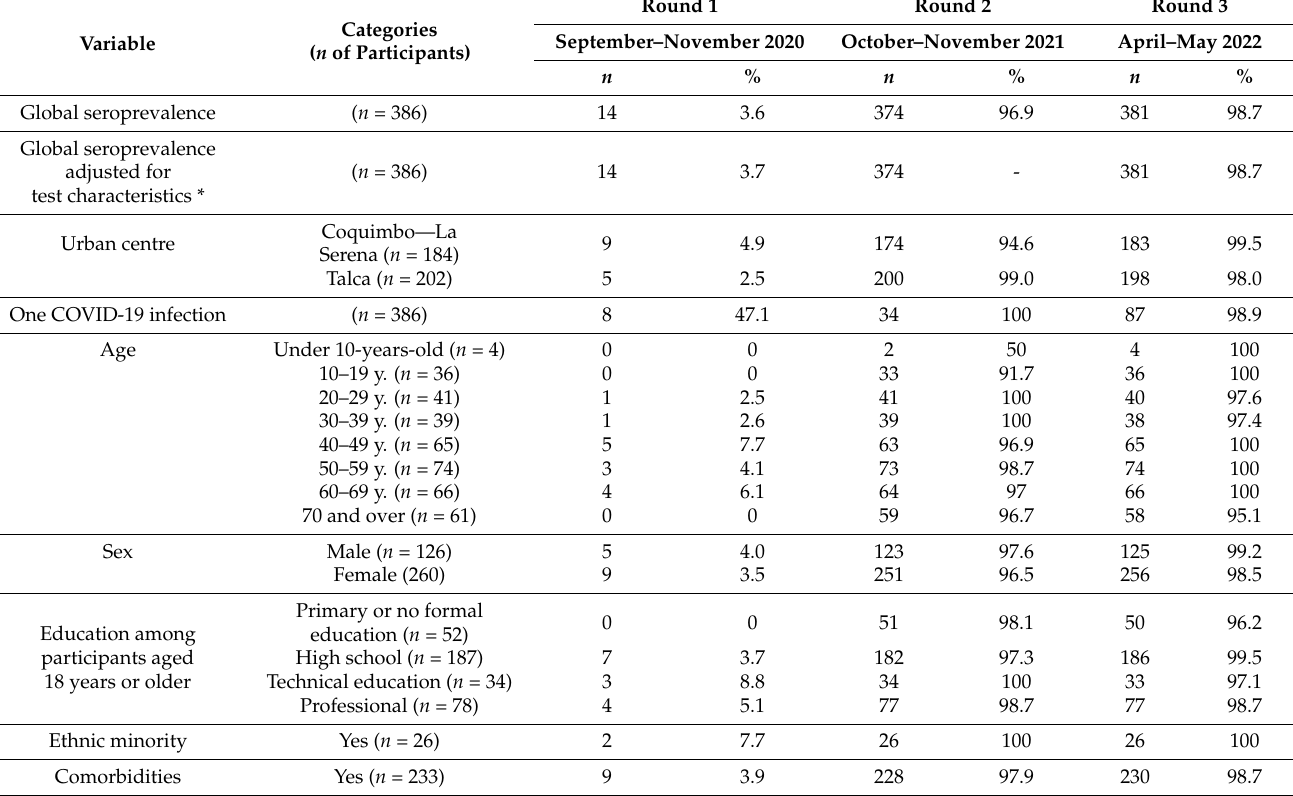
Table 2. Seroprevalence rates according to variables of interest in the participants in the three